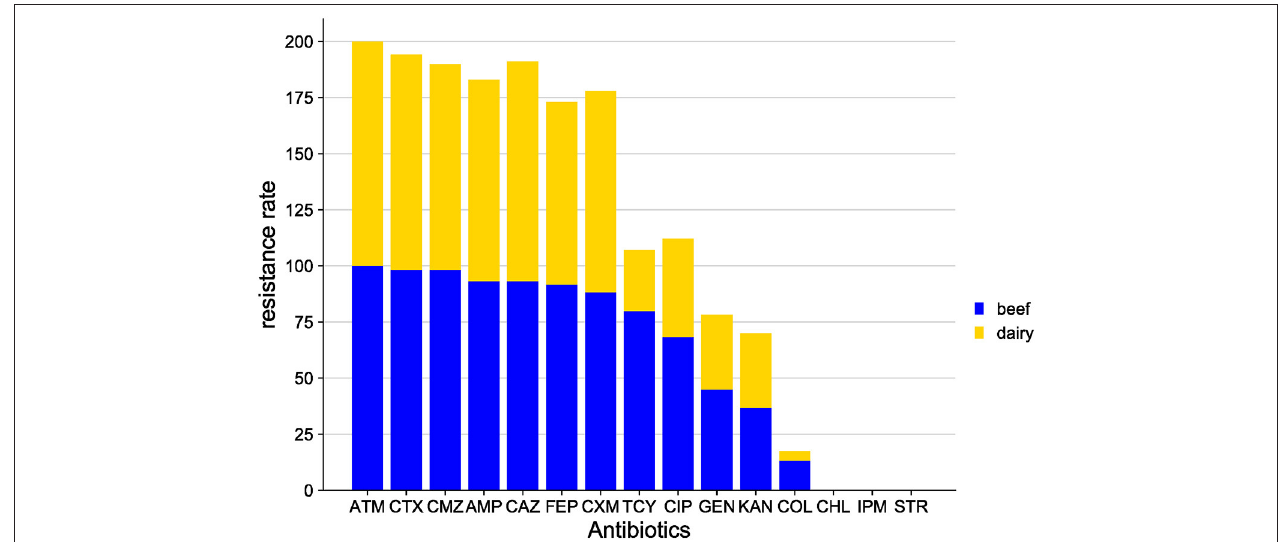
FIGURE 3 | Distribution of antibiotic resistant phenotypes in E. coli from Shandong Province.